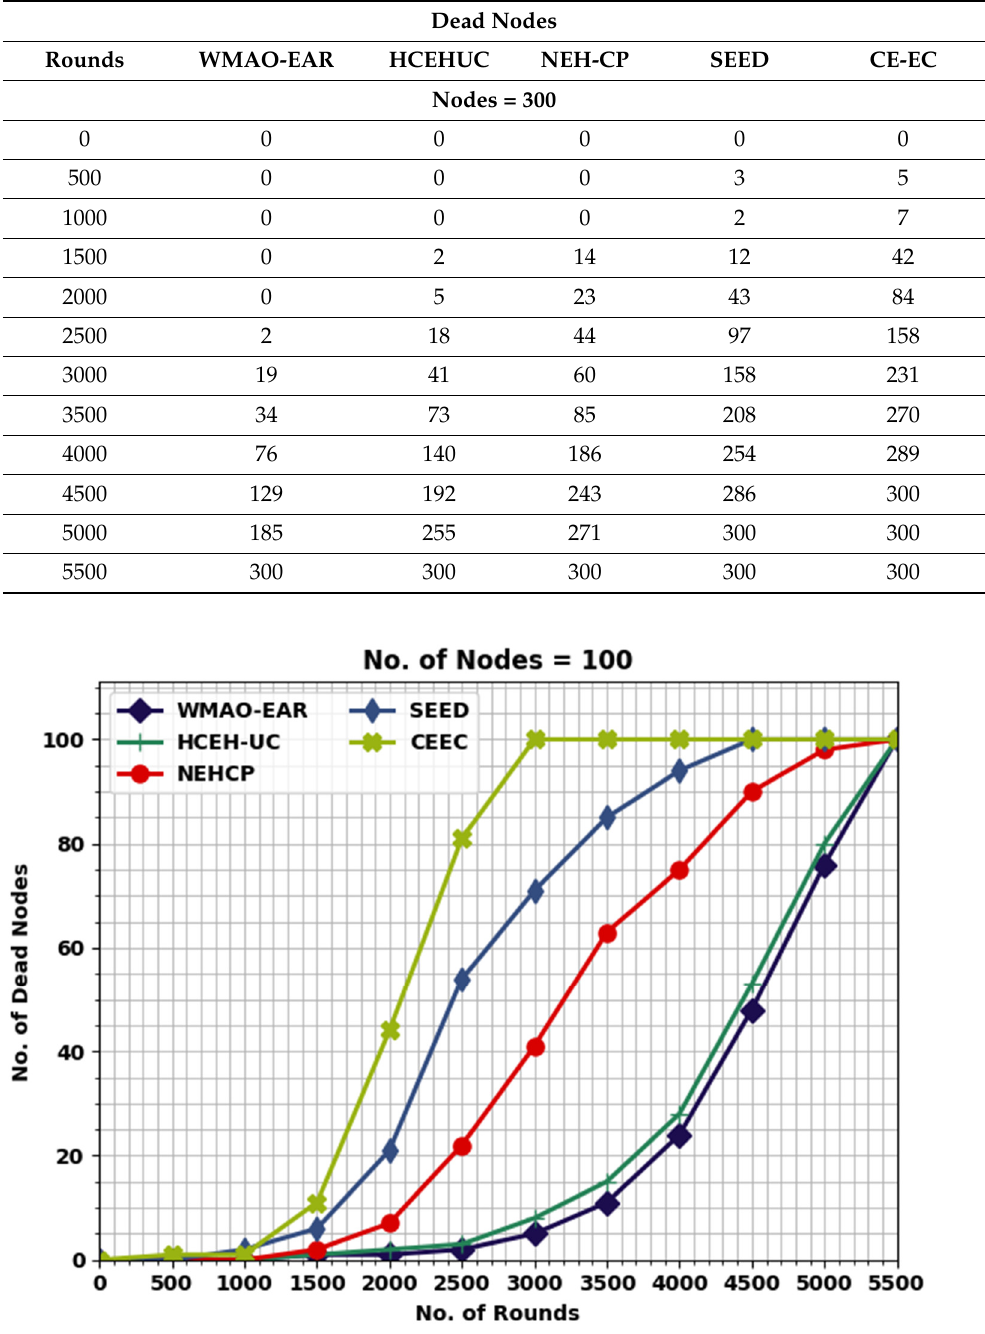
Figure 9. NODN analysis of WMAO-EAR approach under NC of 100.